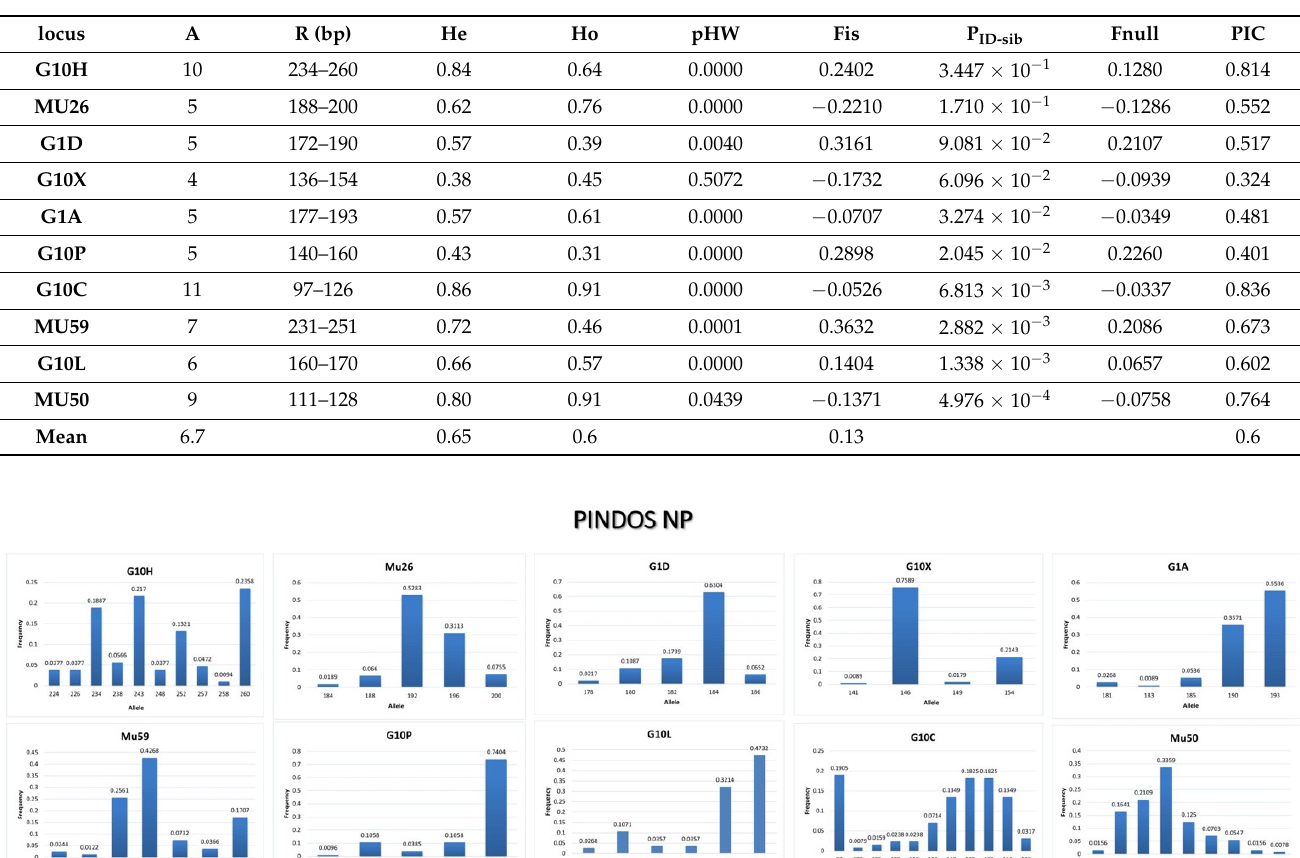
Table 5. Genetic information about the population of brown bears from Pindos NP. Number of alleles (A); allele size per bp (R); observed heterozygosity (Ho); expected heterozygosity (He); p -value for Hardy–Weinberg Equilibrium (pHW); inbreeding coefficient (Fis); probabilities of identity (P ID-sib ); frequency of null alleles (Fnull); polymorphic information content (PIC).